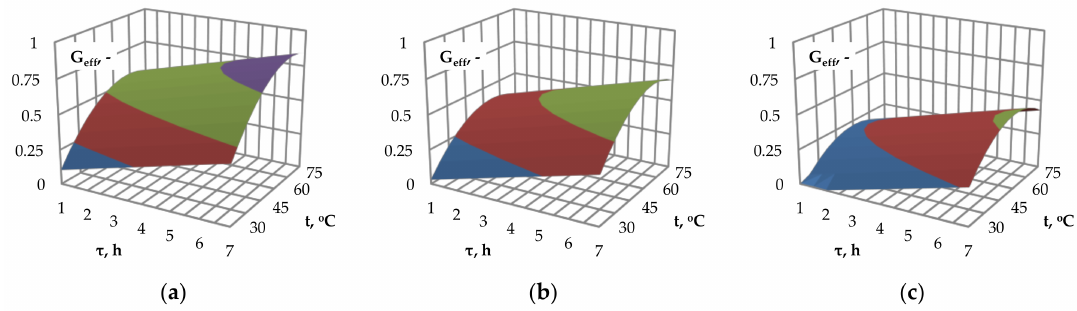
Figure 2. Influence of the pre-treatment time and temperature on the glucose efficiency for the catalyst (NaOH) concentration of 7%: ( a ) Granulation 0.25 mm; ( b ) Granulation 2 mm; ( c ) Granulation 4 mm.